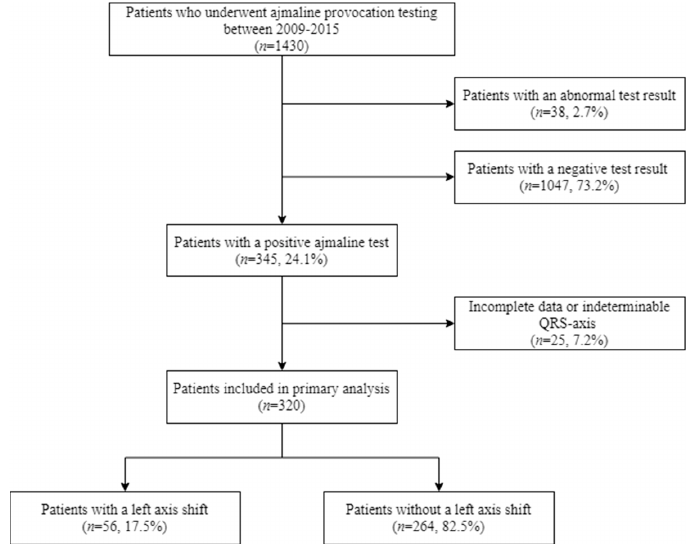
Figure 1. Flowchart of the patient selection. Table 1. Baseline characteristics.